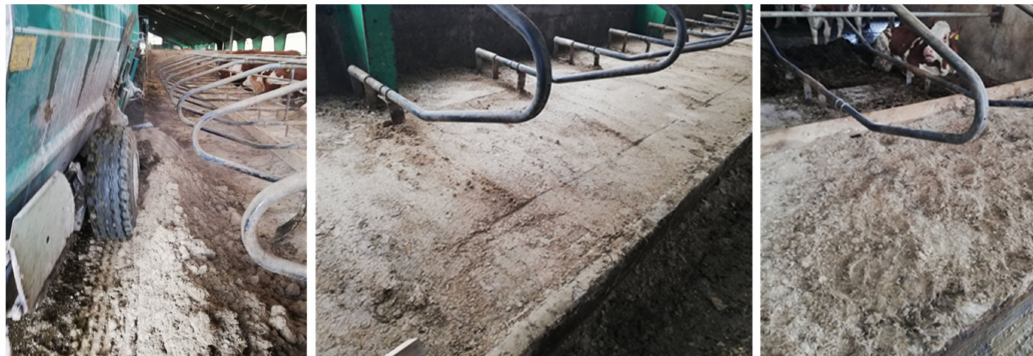
Figure 6. Dosing of the bedding with improved composition and its final adaptation to the cubicles. Photo by Zigo F.